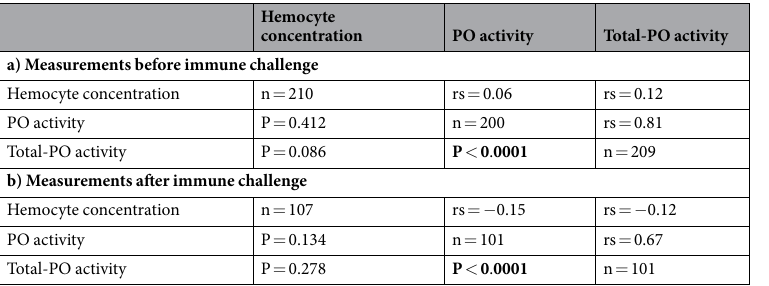
Table 2. Spearman correlation tests among hemocyte concentration, PO, and total-PO activities measured (a) before and (b) after pricking. Significant P-values are in